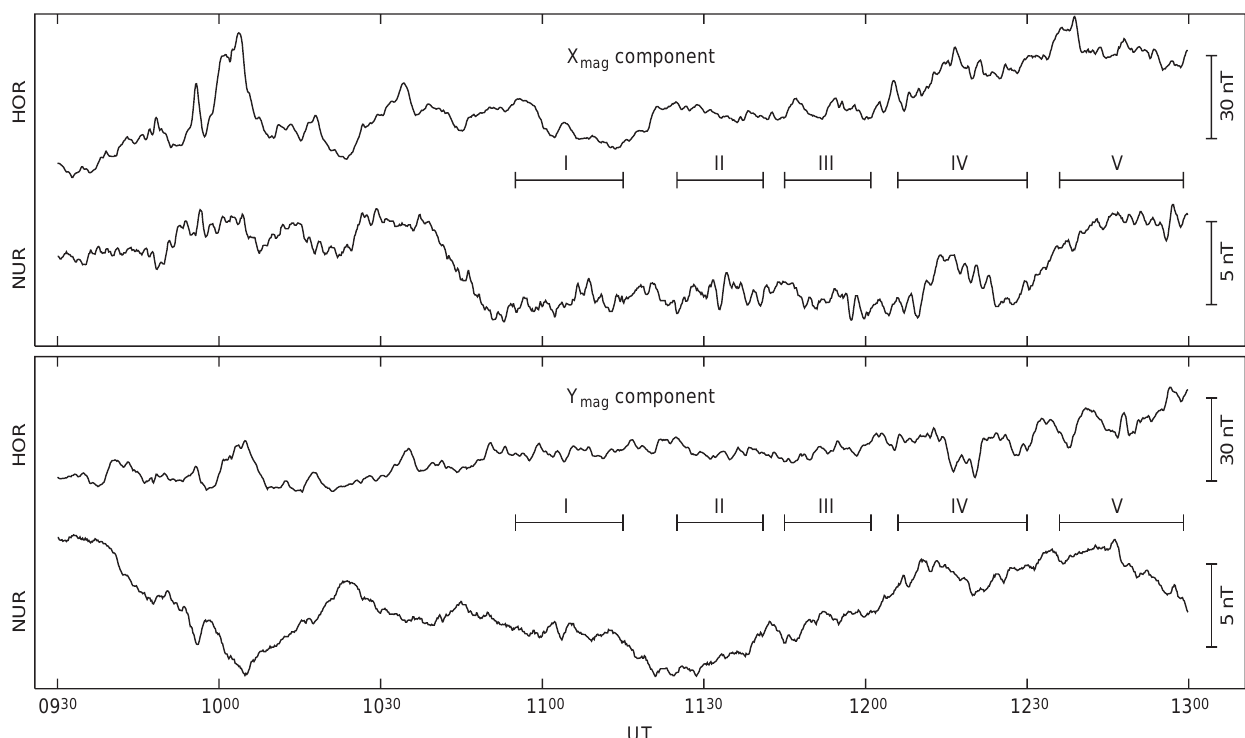
Fig. 10. X and Y component magnetograms from the study interval for a high-latitude (HOR) and mid-latitude (NUR)